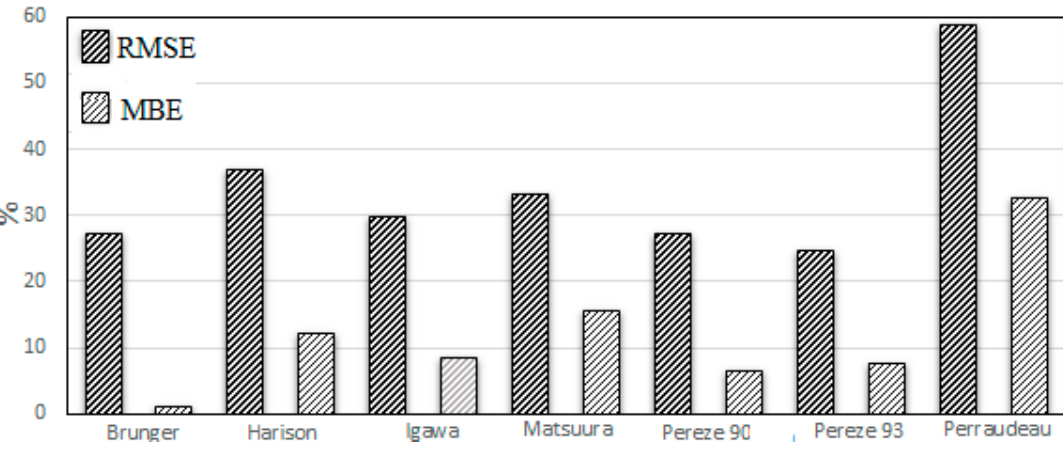
Figure 6. RMSE and MBE for the investigated models (clear sky).